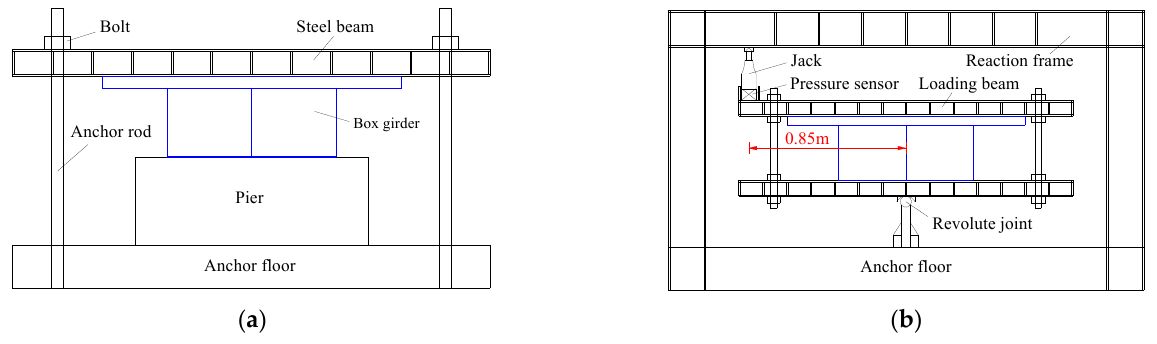
Figure 7. Test loading device: ( a ) beam end section; ( b ) mid-span section.